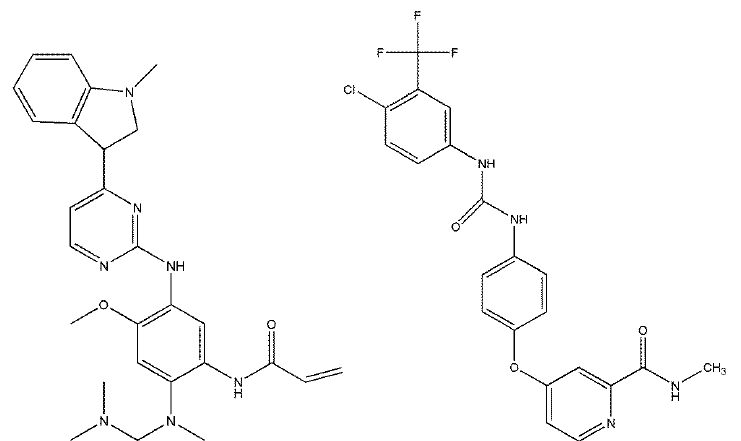
Figure 1. Structures of osimertinib (molecular weight = 499.619 Da) and sorafenib (molecular weight = 464.825 Da).